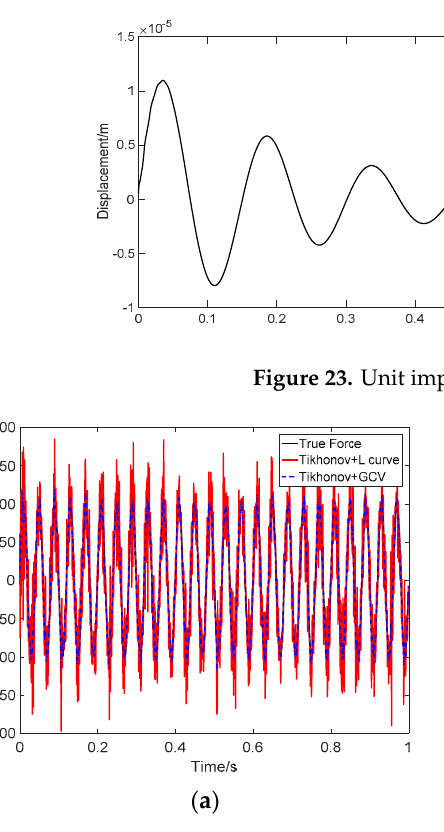
Figure 22. Cantilever model.